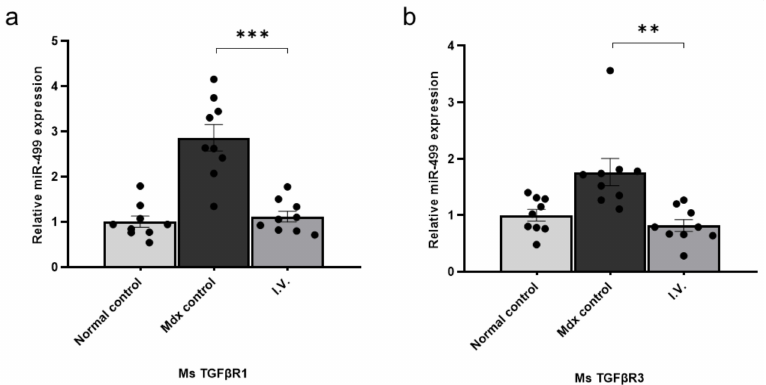
Figure 3. Transforming growth factor β receptor (TGF β R)1 and TGF β R3 are direct targets of miR- 499-5p ( a ) Relative TGF β R1 expression levels were measured in skeletal muscles from each group. Glyceraldehyde 3-phosphate dehydrogenase (GAPDH) was used as an endogenous control, and data are expressed as the mean ± the SEM. Bars with different superscripts indicate significantly different values. ( b ) Relative TGF β R3 expression levels were measured in the skeletal muscle of each group. GAPDH was used as an endogenous control, and data are expressed as mean ± SEM (** p < 0.01, *** p < 0.001).